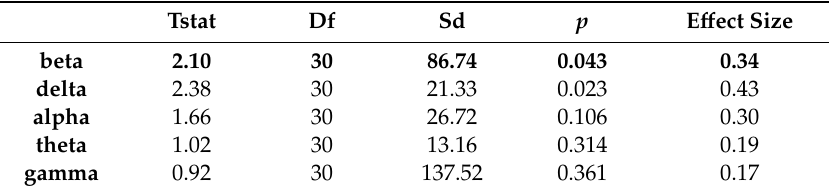
Table 4. t -test table for the parietal region (all bands) of the HERA model.